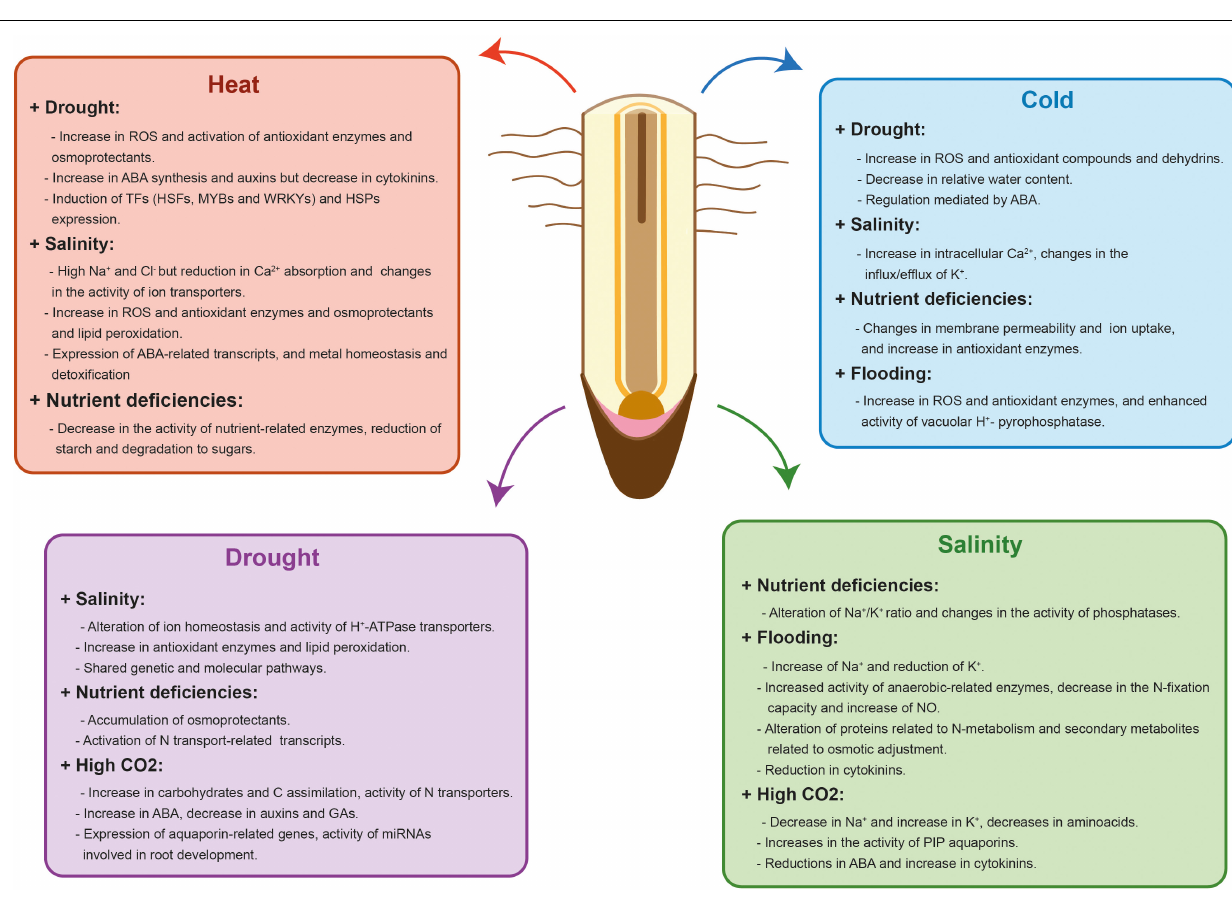
FIGURE 2 | Physiological, biochemical, hormonal and molecular effects of different abiotic stress combinations in plant roots. Red, blue, purple, and green charts show the physiological, biochemical, hormonal and molecular effects that occur in each stress combination. Some of these responses are similar between stresses but plants also trigger specific responses that are tailored to a particular stress combination. In addition, two abiotic stresses that are occurring simultaneously can aggravate or benefit crop survival and